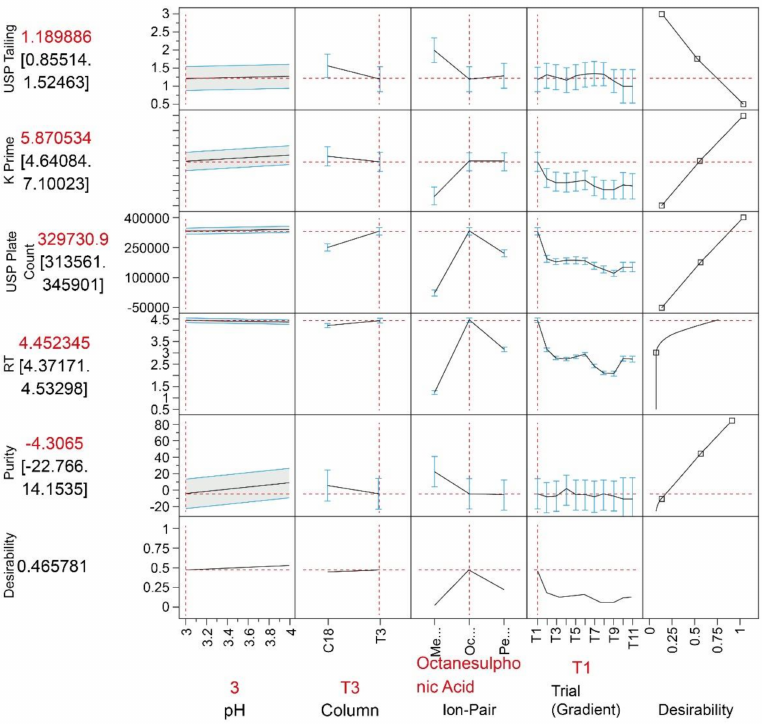
Figure 5. Prediction profiler with 95% confidence intervals. An overall desirability of 47% could be achieved with the setting